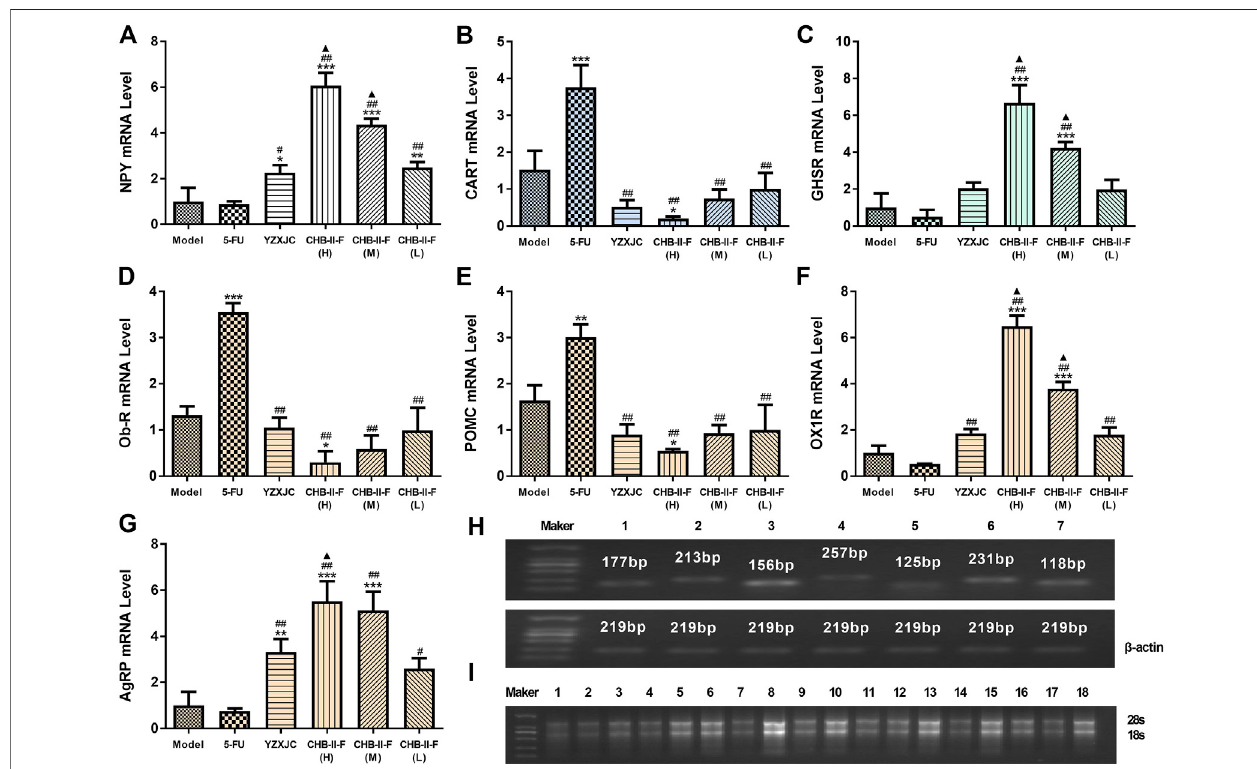
FIGURE 6 | Effects of CHB-II-F on mRNA expression of NPY, AgRP, POMC, CART, OX1R, Ob-R,., and GHSR in the hypothalamus of the transplanted H 22 hepatocellular carcinoma model mice receiving chemotherapy ( x ± s , n (cid:2) 6). (A) NPY mRNA expression in different groups. (B) CART mRNA expression in different groups. (C) GHSR mRNA expression in different groups. (D) Ob-R mRNA expression in different groups. (E) POMC mRNA expression in different groups. (F) OX1R mRNA expression indifferentgroups. (G) AgRPmRNA expressionindifferentgroups. (H) Gel electrophotogramoftargetgeneNPY, AgRP,POMC,CART,OX1R, Ob-R, GHSR, and β -actin ampli fi cation products of real-time fl uorescent quantitation polymerase chain reaction (RTFQ-PCR). 1: AgRP; 2: NPY; 3: POMC; 4: CART; 5: OX1R; 6: Ob-R; 7: GHSR. (I) Gel electrophotogram of total RNA of tumor tissue. Randomly select three samples from each group and verify their integrity. 1 – 3: saline- treatedcontrols(model); 4 – 6:5-FU treatedcontrols(0.02 g/kg);7 – 9:YZXJC (0.78 g/kg);10 – 12:CHB-II-F(H)(65 g/kg);13 – 15:CHB-II-F(M) (32.5 g/kg);16 – 18:CHB-II- F(L) (16.25 g/kg). Statistical analysis: * p < 0.05, ** p < 0.01, *** p < 0.001 compared with the model (saline) group. # p < 0.05, ## p < 0.01 compared with the 5-FU group. ▲ p < 0.05 compared with the YZXJC